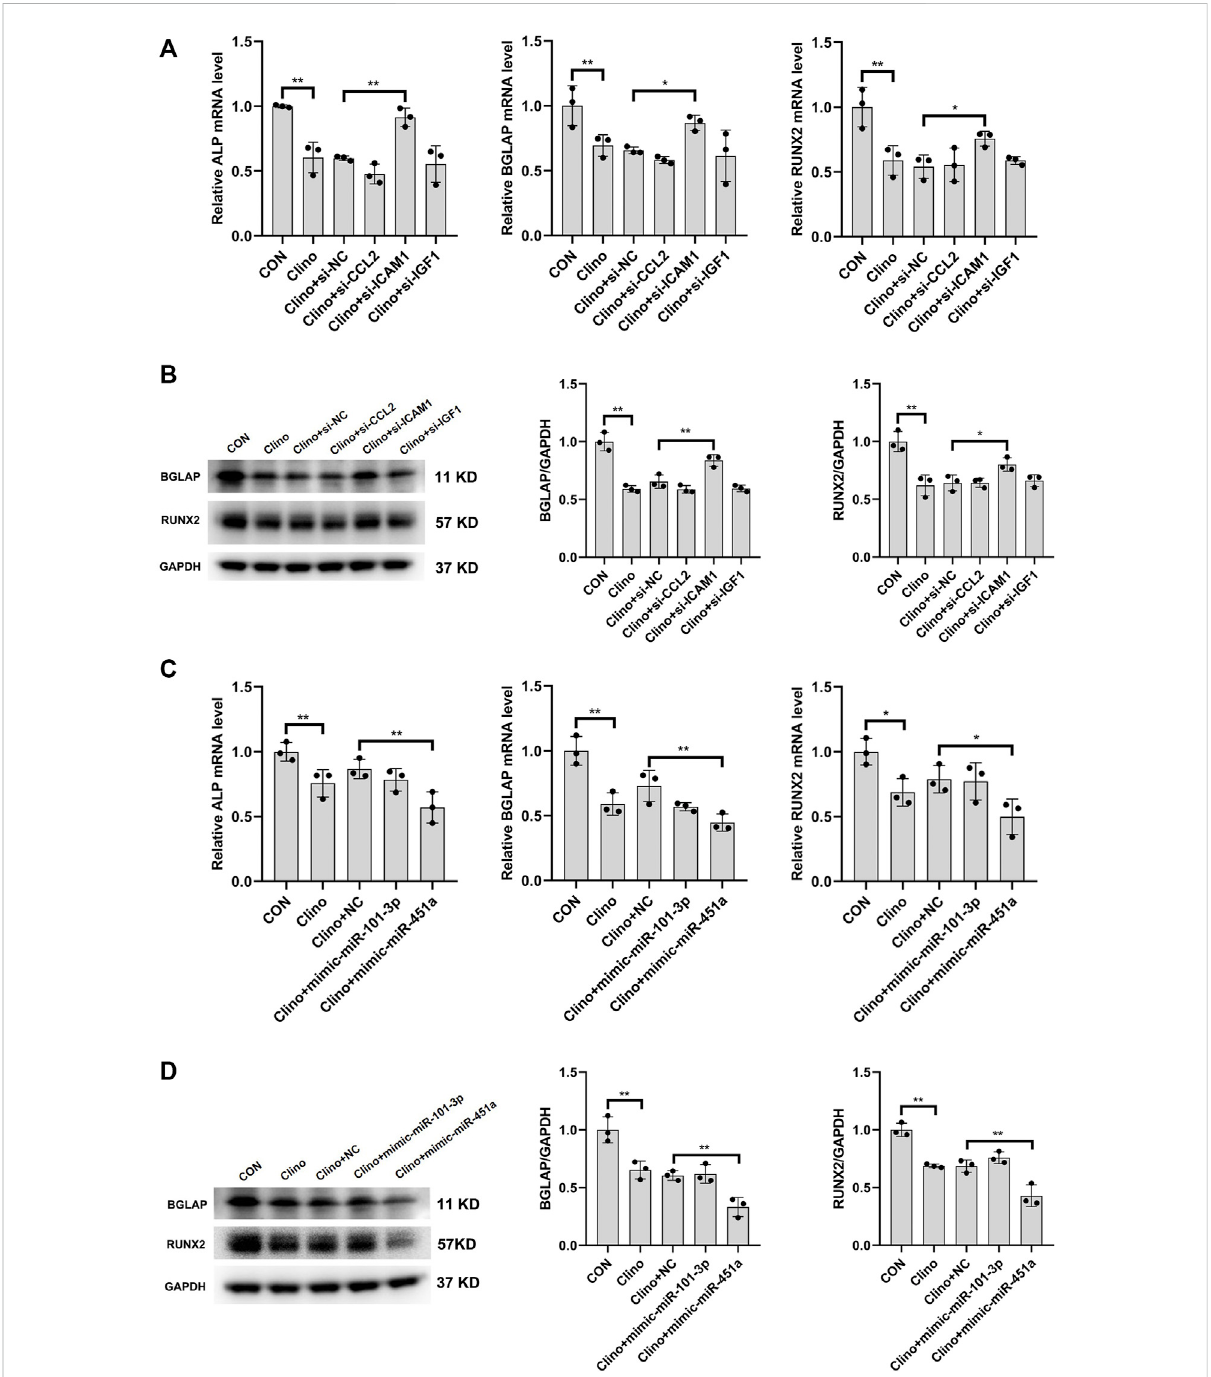
FIGURE 6 The effects of the identi fi ed clinorotation-sensitive genes and miRNAs on osteogenesis of hMSCs under clinorotation condition hMSCs were transfected with siRNA-NC or siRNA – genes and cultured in osteogenic medium under clinorotation condition for 72 h, and were then subjected to qRT-PCR analysis of ALP, BGLAP and Runx2 mRNA levels (A) , western blot analysis of BGLAP and Runx2 protein expression (B) (n = 3). hMSCs were transfectedwithmimic-miRNA-NCormimic-miRNAandculturedinosteogenicmediumunderclinorotationconditionfor72 h,andwerethen subjectedtoqRT-PCRanalysisofALP,BGLAPandRunx2mRNAlevels (C) ,westernblotanalysisofBGLAPandRunx2proteinexpression (D) (n=3).All data are the mean ± SD. * p < 0.05, ** p <